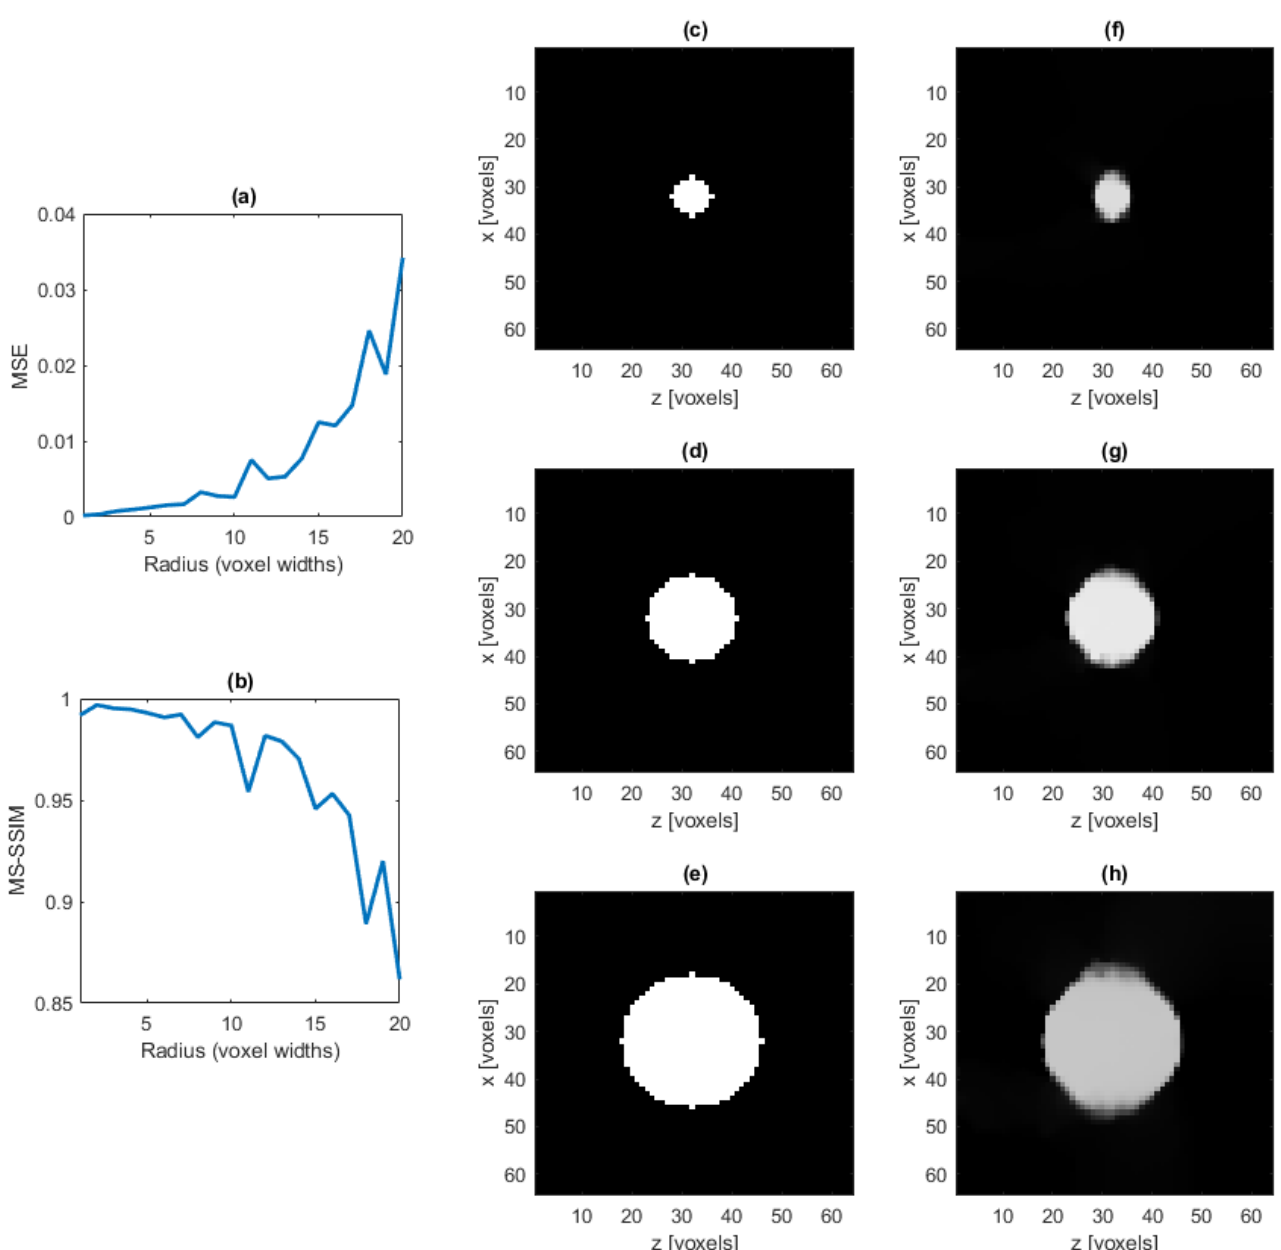
Figure 6. Average MSE ( a ) and average MS-SSIM ( b ) of the reconstructed cylinder IPD with varying radius, averaged over five trials for each radius value considered. A cross section of the ground truth cylinder with radius of five ( c ), ten ( d ) and fifteen ( e ) voxel widths and a cross section of the reconstruction of the same cylinder, respectively, ( f – h ). Each cylinder considered is orthogonal to the xz